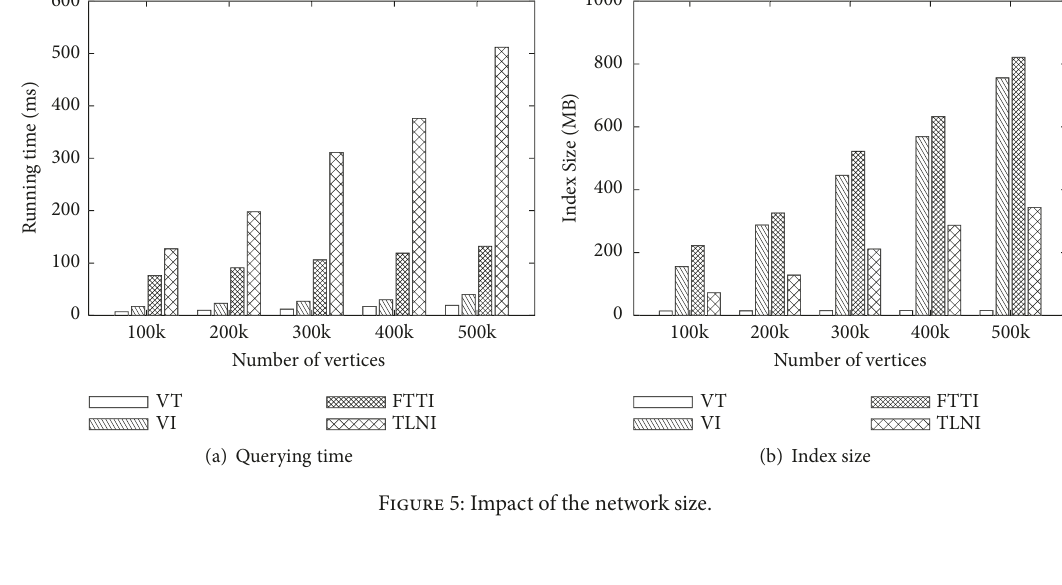
Figure 5: Impact of the network size.